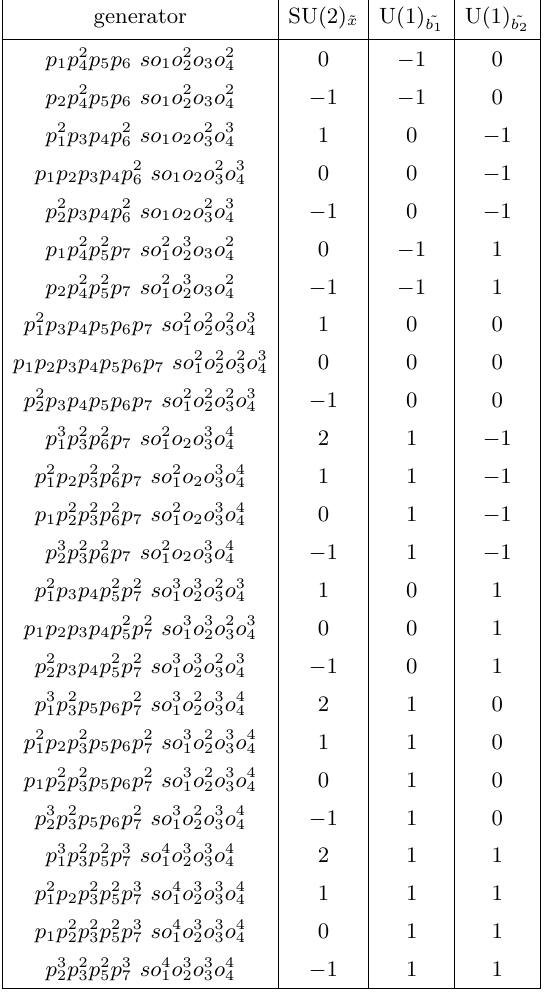
Table 56 . The generators and lattice of generators of the mesonic moduli space of Model 14 in terms of brick matchings with the corresponding flavor